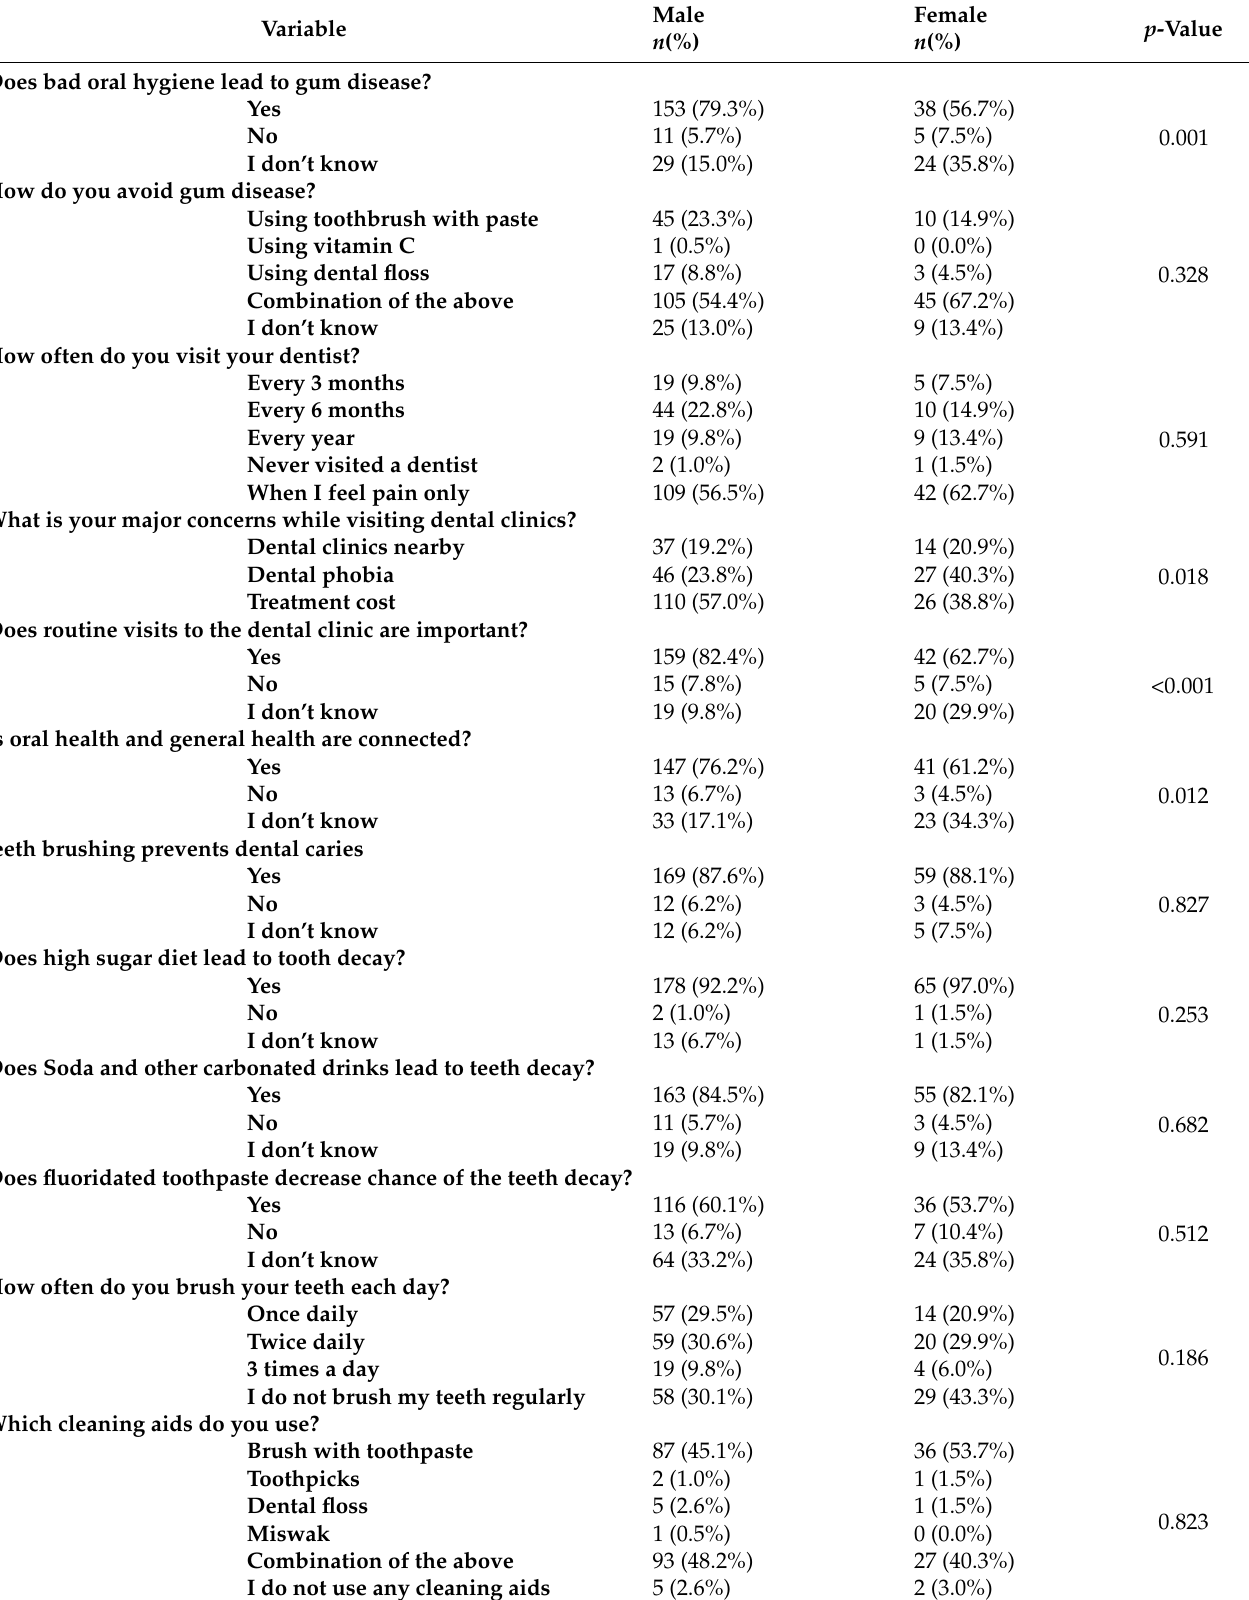
Table 4. Association of knowledge, attitude and practices towards oral health maintenance with respect to